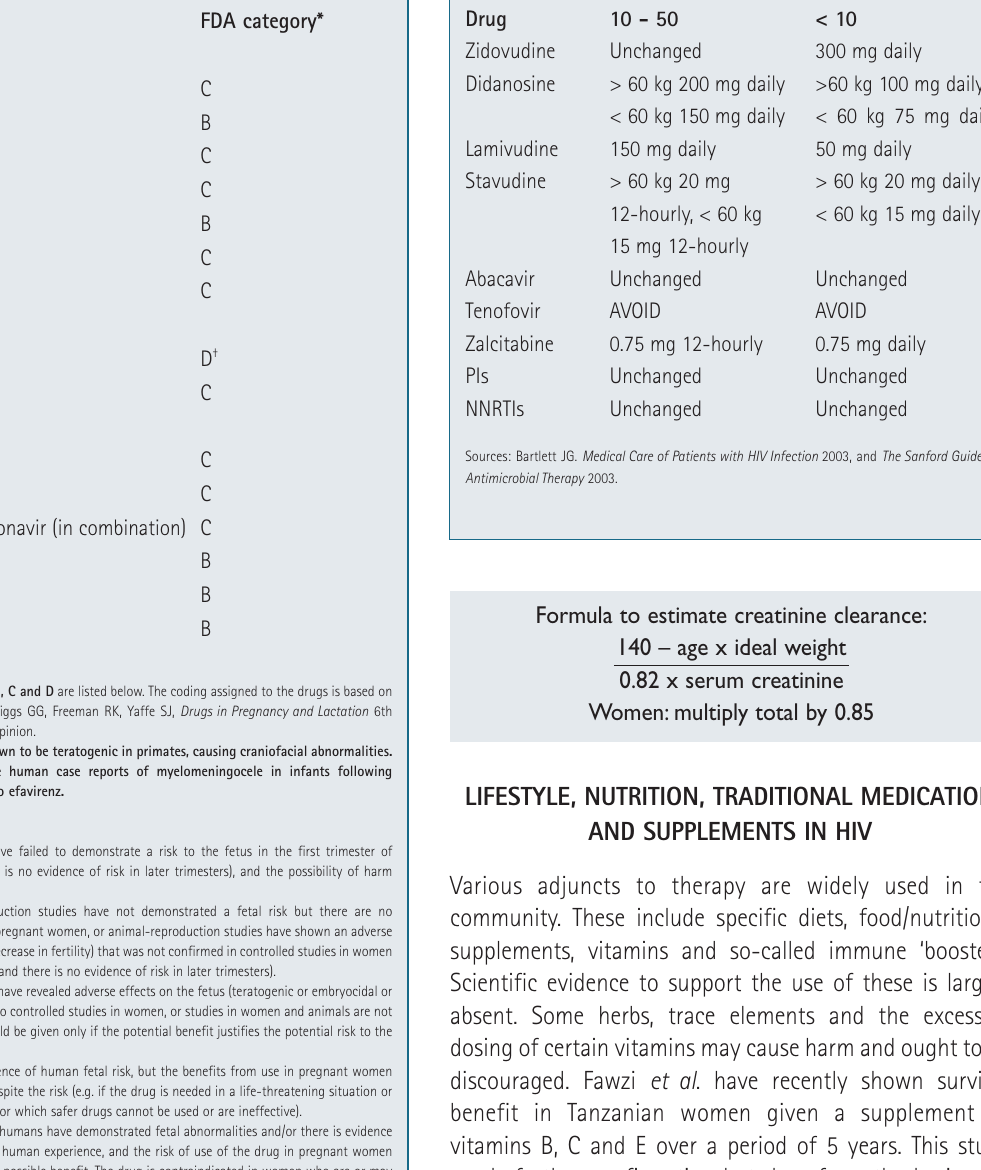
TABLE III. RISK FACTORS IN PREGNANCY Creat.